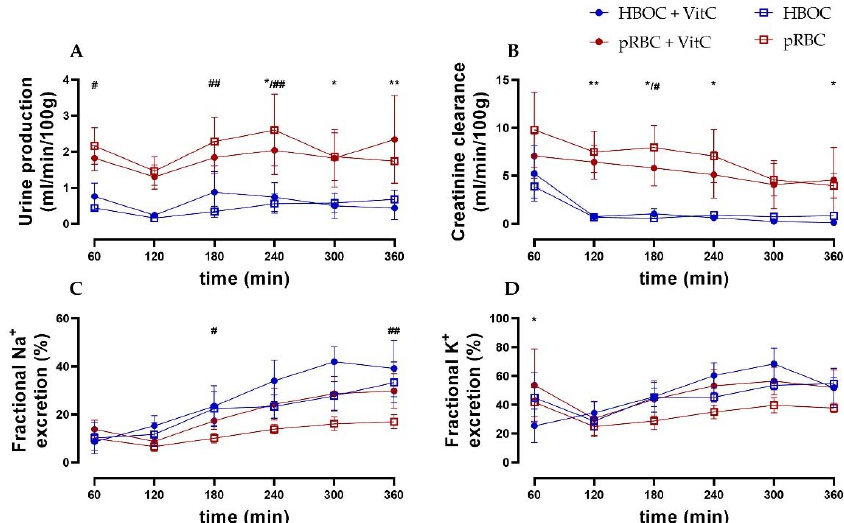
Figure 3. ( A ) Urine production was higher in both pRBC groups compared to the HBOC groups. ( B ) Creatinine clearance in the HBOC groups decreased considerably after 120 min, while the pRBC groups maintained a significantly higher level. ( C ) Fractional sodium and ( D ) fractional potassium excretion showed a tendency towards lower salt excretion in the pRBC than in the HBOC groups; * p < 0.05, ** p < 0.01 (HBOC + VitC vs. pRBC + VitC), # p < 0.05, ## p < 0.01 (HBOC vs. pRBC).